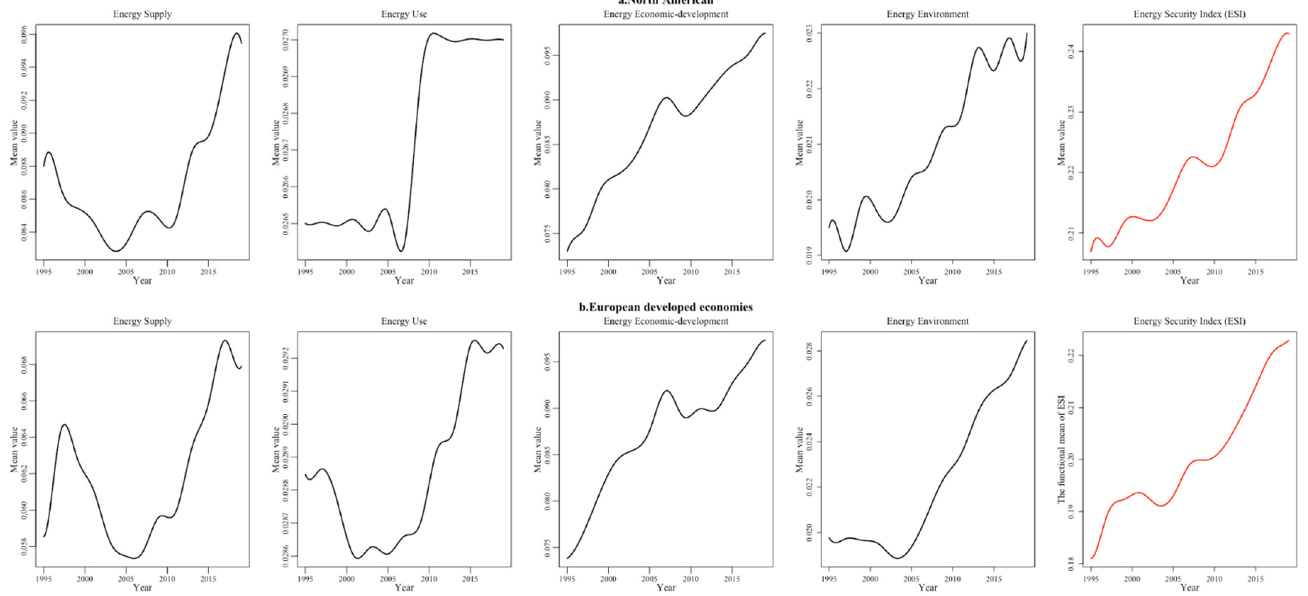
Figure 7. “Best” regional energy security system performance in four dimensions.